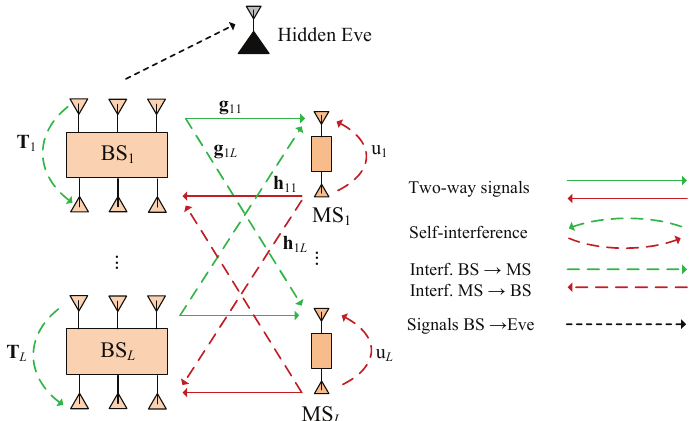
Figure 1. Secure two-way network with SWIPT and hidden